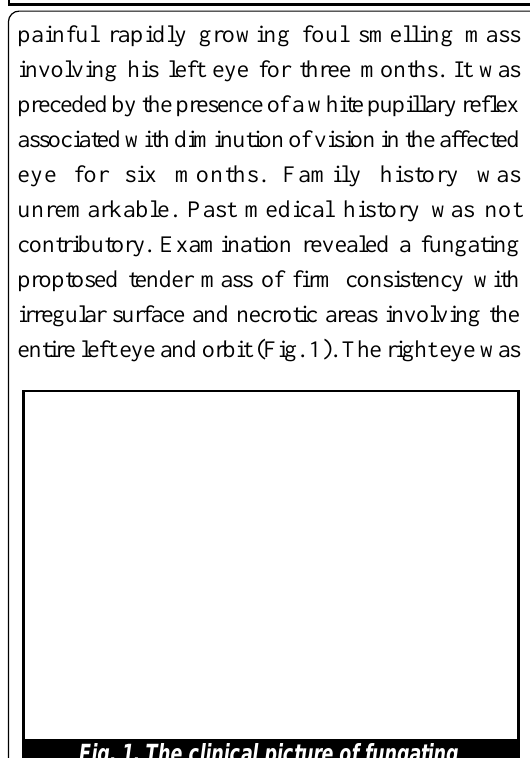
Fig. 1, The clinical picture of fungating proptosed mass in the left orbit.